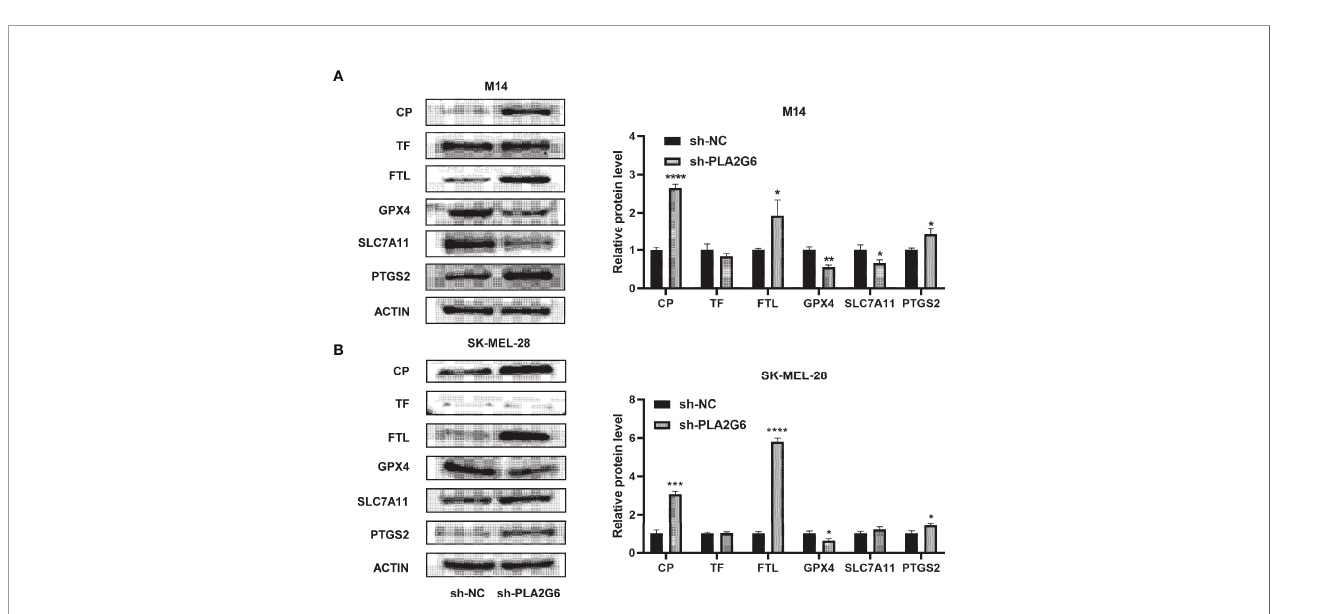
FIGURE 8 | Validation of the expression of ferroptosis-related proteins by western blotting in PLA2G6 knockdown SK-MEL-28 (A) and M14 cells (B) . * P < 0.05, ** P < 0.01, *** P < 0.001, **** P <